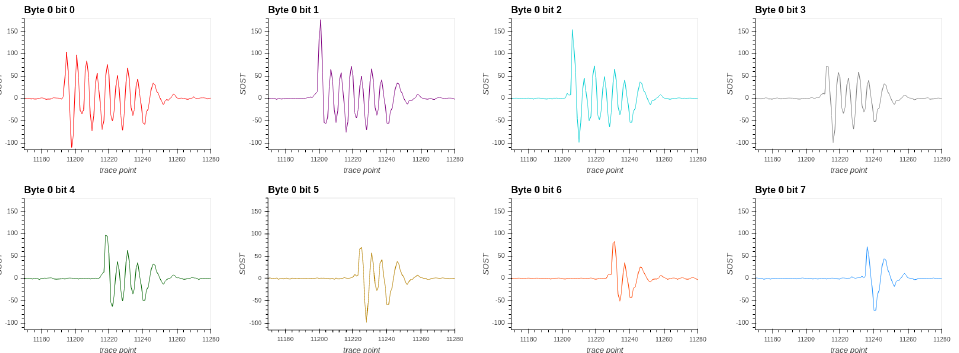
Figure 10: The t-test results for POL2MSG() separately for each